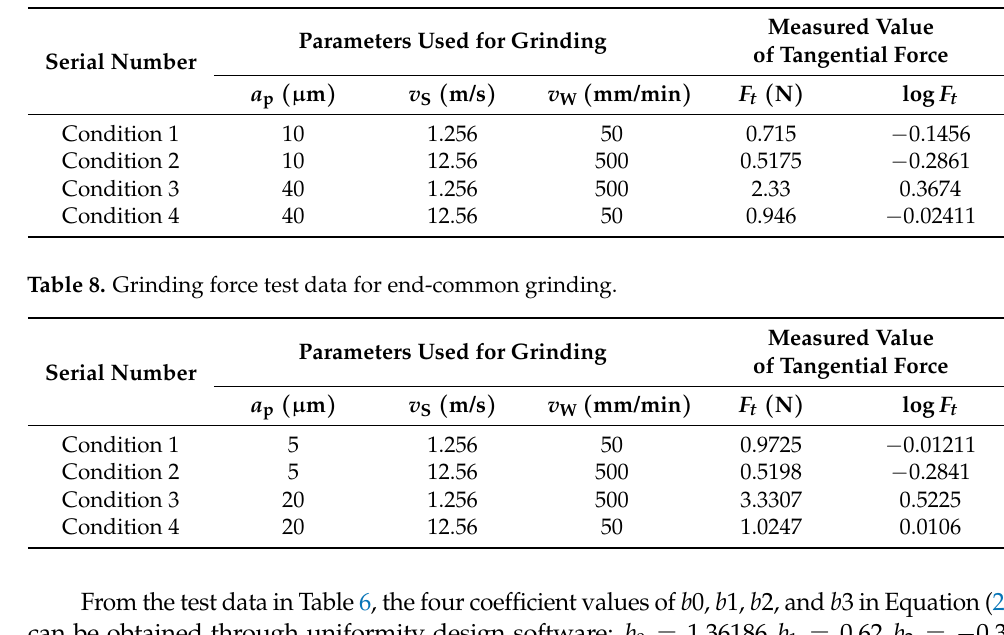
Table 7. Grinding force test data of side-ultrasonic assisted grinding.